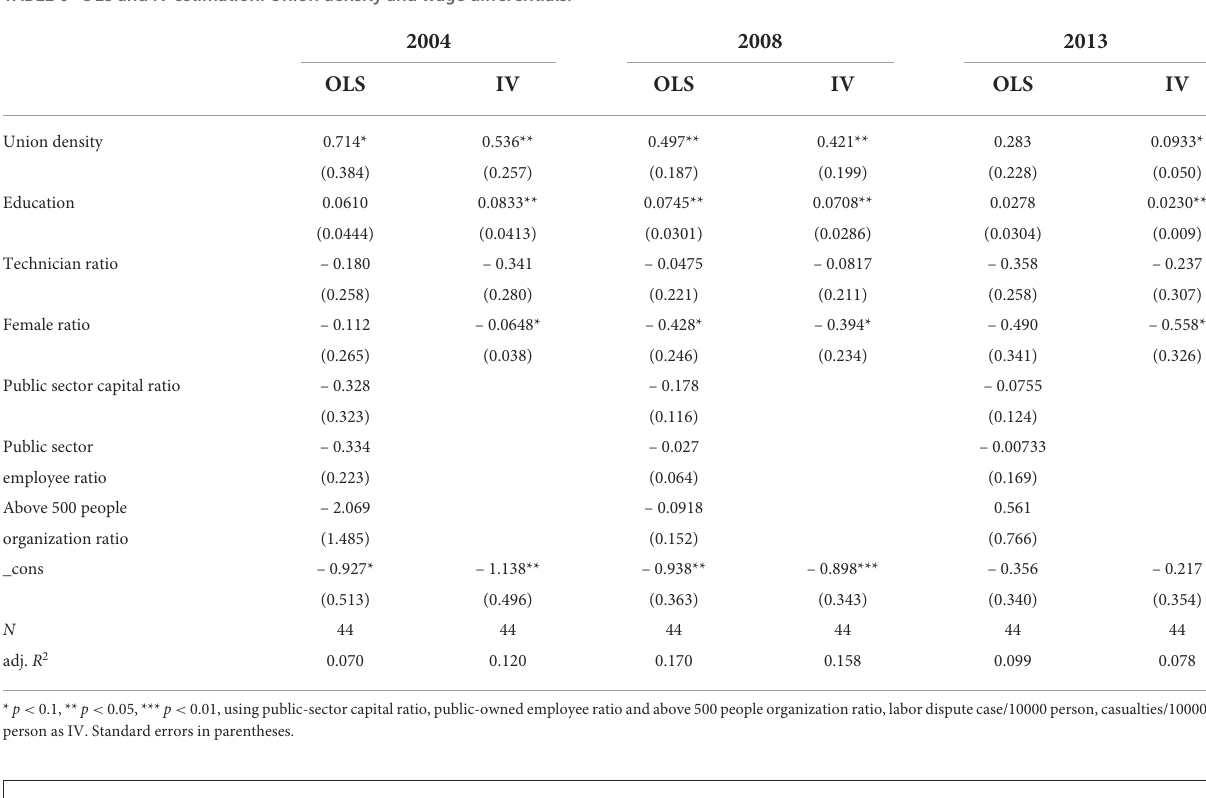
TABLE 6 OLS and IV estimation: Union density and wage differentials.